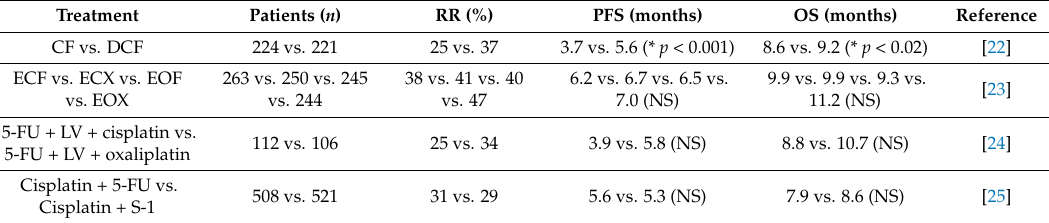
Table 1. Major phase III clinical trials of first-line cytotoxic agents in metastatic/advanced gastric carcinoma.